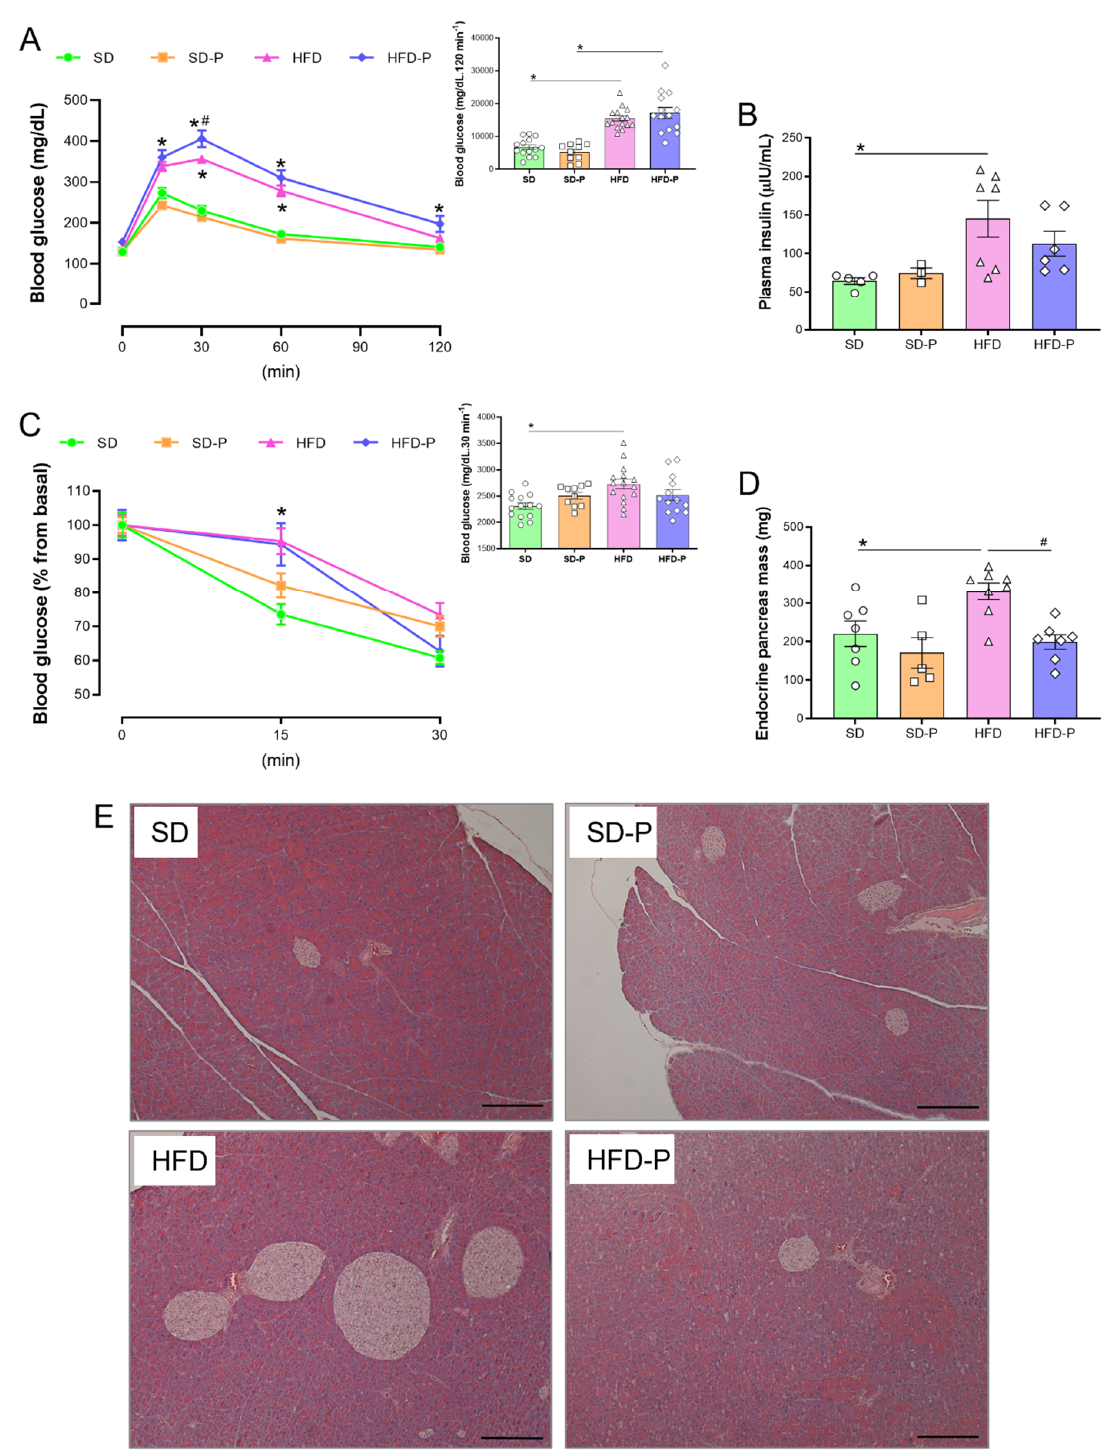
Figure 2. Pep19 oral treatment prevents HFD-induced hyperinsulinemia and increase in the absolute mass of endocrine pancreas. ( A ) Glucose tolerance test, graphic and area under the curve (AUC; inset). ( B ) Plasma insulin ( µ IU/mL). ( C ) Insulin tolerance test, graphic and AUC (inset). ( D ) The absolute mass of the endocrine pancreas. ( E ) Representative pictures from pancreas sliced sections stained with hematoxylin and eosin (H&E). Scale bar, 200 µ m. Data expressed as mean ± SEM. n = 4–15 per group. *, p < 0.05 between SD vs. HFD; #, p < 0.05, HFD vs. HFD-P. Statistical analyses were performed using either Two-way ANOVA with Tukey’s post-hoc test ( A , C ) or unpaired t -test (insets from ( A – D